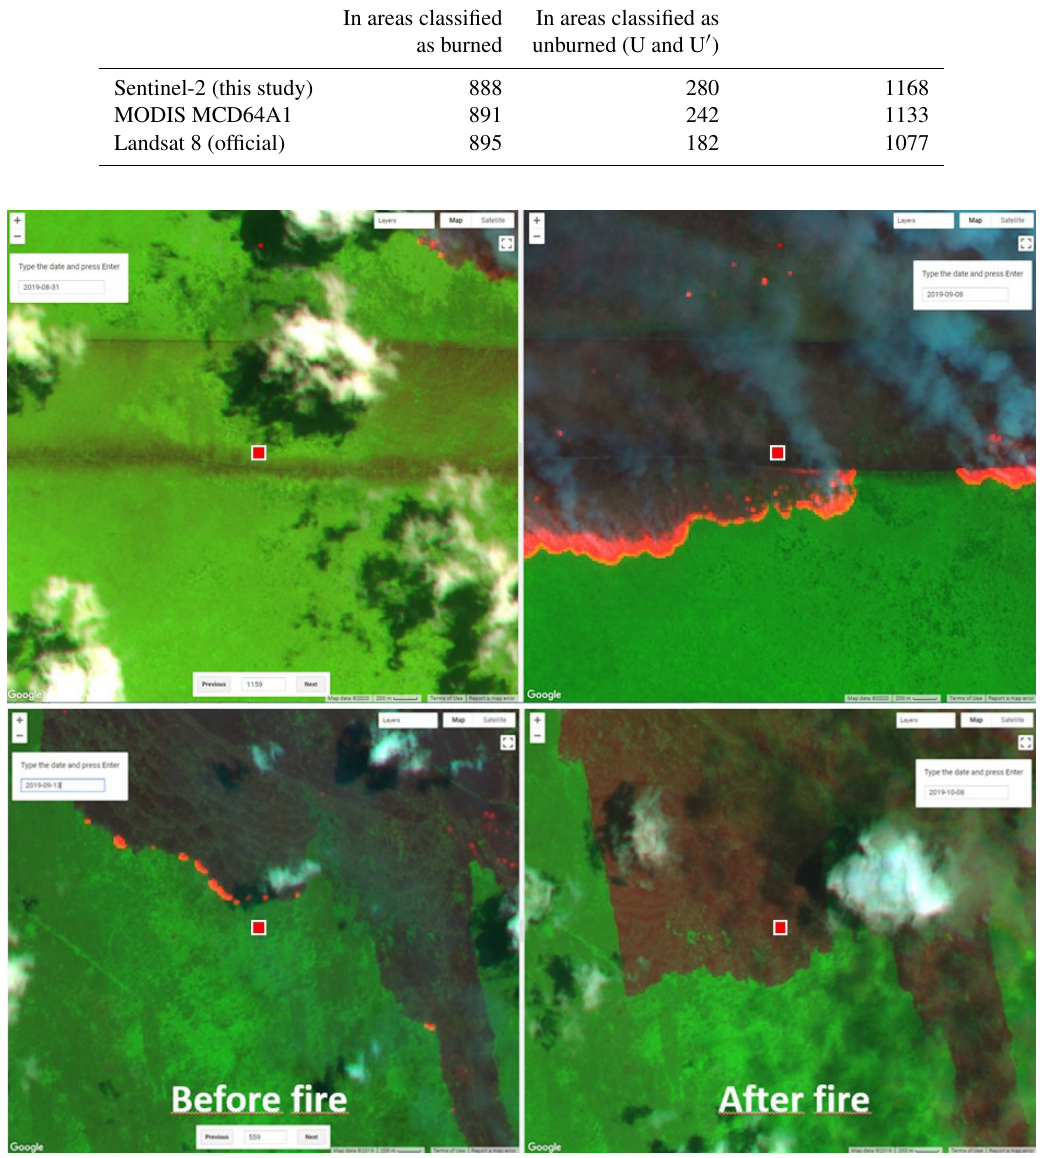
Figure 4. Two snapshots recording the pre-fire (left panel) and post-fire (right panel) original Sentinel-2 images acquired shortly before (13 September 2019) and shortly after (8 October 2019) fire for two reference sites (red squares). Imagery displayed in RGB: SWIR, NIR, and red. Sentinel-2 provides two SWIR bands. Band 12 = 2 . 190µm is more suitable than Band 11 = 1 . 610µm to detect the intense heat from flaming fronts. On these image pairs, one can see flaming fronts travelling towards the reference sites (red dot) from the north in the pre-fire images (left) and sharp changes in colour from green to dark red characteristic of charred remains with continuing flaming in the post-fire images (right). Layout built using ©Google Earth